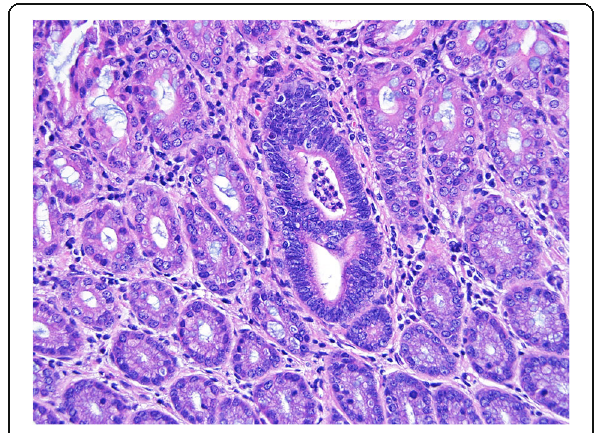
Fig. 2 A single adenomatous crypt in the small intestine of an Apc Min/+ mouse, composed of a dilated cystic invagination into the villu